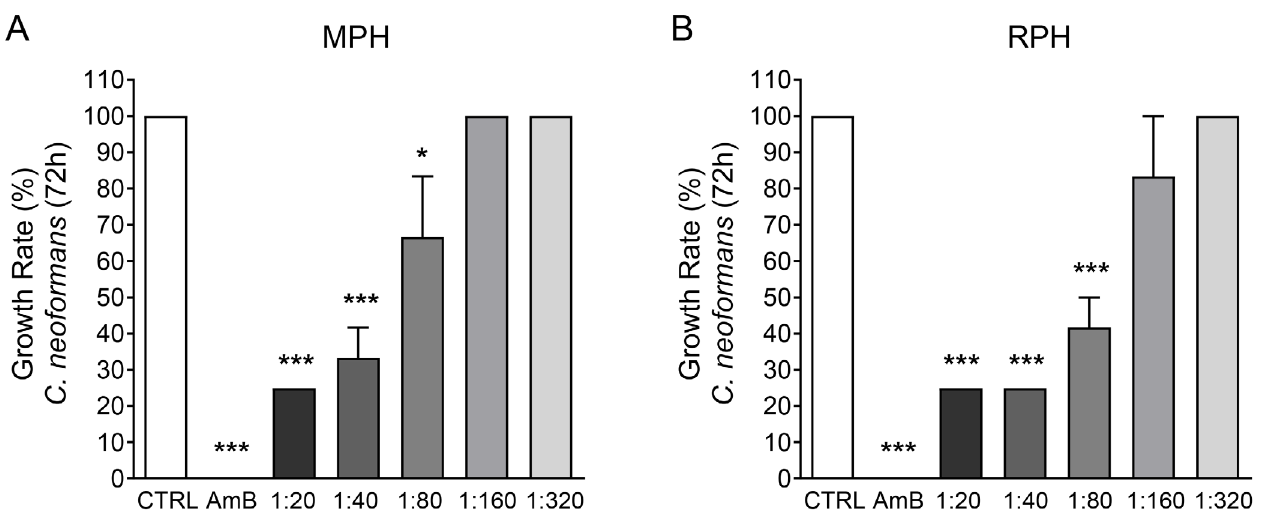
Figure 1. The hemolymph of two hematophagous insects, Meccus pallidipennis and Rhodnius prolixus , affects in a dose-dependent manner the growth of Cryptococcus neoformans . The bars represent the growth rate of C. neoformans in the presence of (A) M. pallidipennis hemolymph (MPH) or (B) R. prolixus hemolymph (RPH). The fungi were incubated with hemolymph for 72 hours, and the growth was determined by optical difference with control (without treatment). Amphotericin B (AmB) was used as a gold standard antifungal control. Data representative of one experiment. The bars represent mean with the standard error of the mean (SEM). All the significances are relative to the control group. * p < 0.05; ** p < 0.01; *** p <